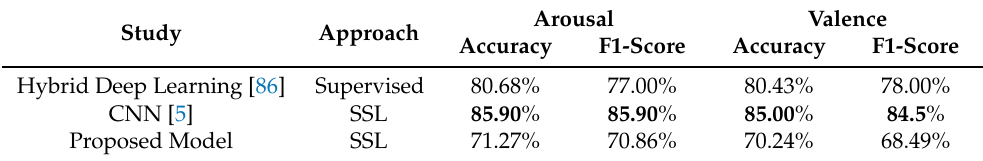
Table 8. Classification results reported by various state-of-the-art works on the DREAMER dataset.